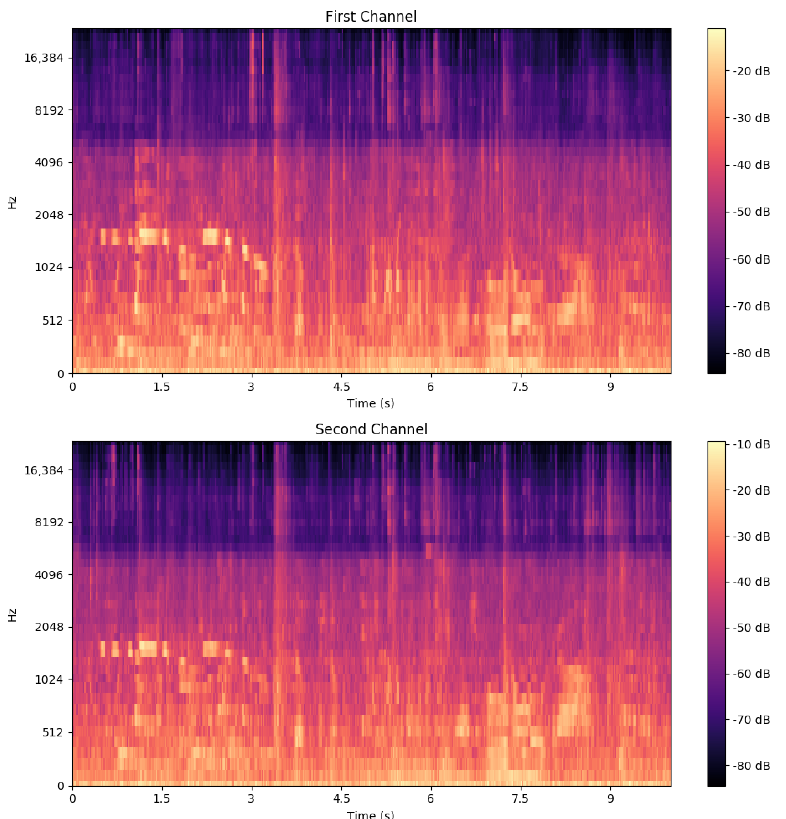
Figure 1. Sample spectrogram from the DCASE 2020 Task 1 Subtask A development dataset. This clip is recorded at an airport. The spectrogram of each channel from the binaural recording is depicted.